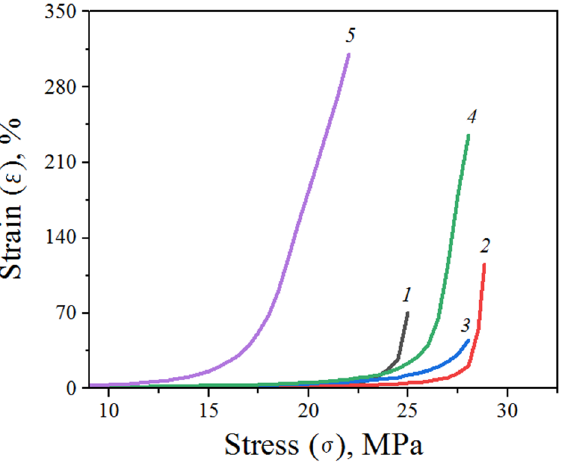
Figure 6. Stress–ultimate strain curves of PLA films (1) and PLA/AONF composite films with dif-